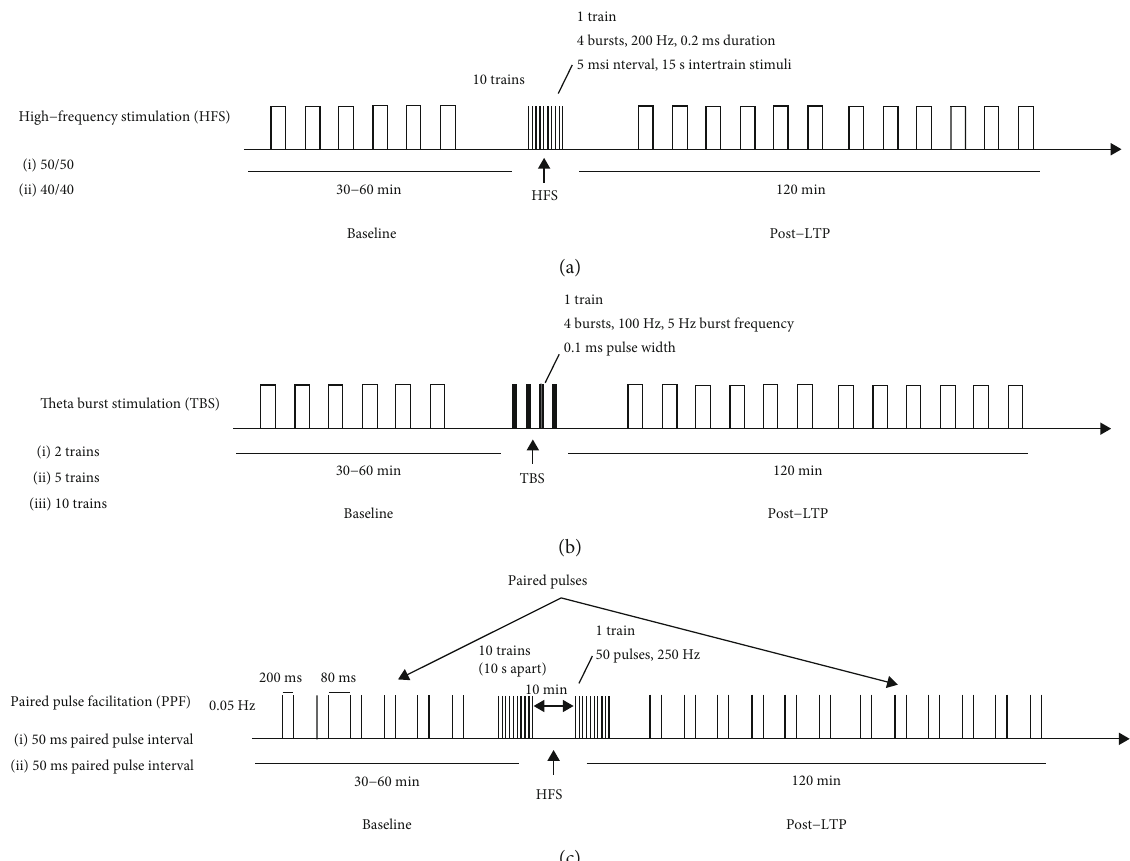
Figure 1: Schematic presentation of electrical stimulation protocols that induce LTP at the SC-CA1 synapses in anesthetized rats. A high- frequency stimulation protocol consists of 10 trains, 1 train consisting of 20 pulses at 200 Hz with (a) a 2s interval between each train, (b) TBS (2 or 5 trains with 5 bursts per train of 4 pulses at 100Hz, 200 μ s), and (c) paired pulses (200ms, 0.05Hz) delivered at di ff erent lengths of interstimulus intervals of 50ms and 30ms before and after the standard 200 Hz HFS